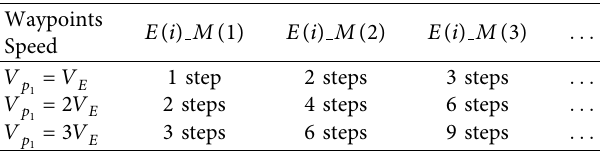
Table 1: Relationship between the movement of E and waypoints in unit period.